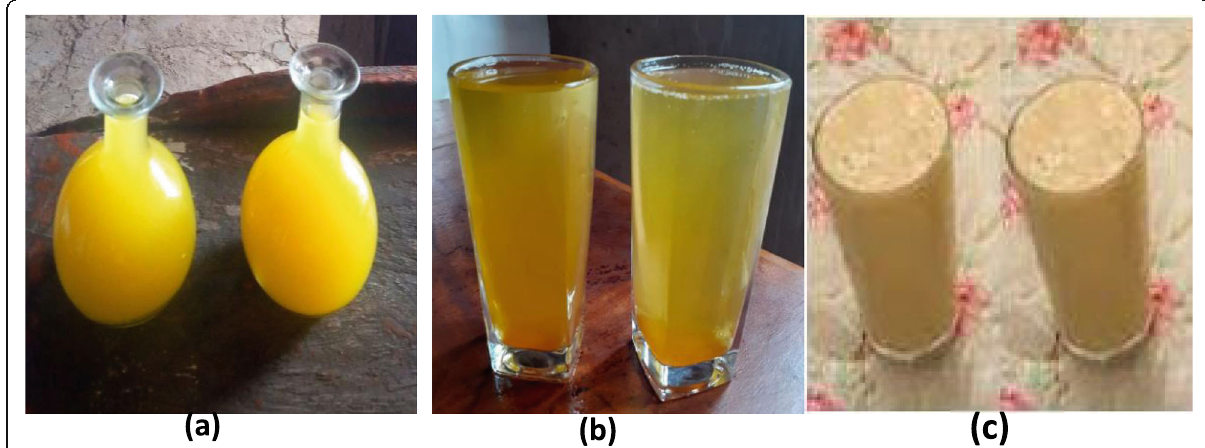
Fig. 4 Pictures of Ethiopian traditional fermented beverages: tej ( a ), grawa ( b ), and borde ( c ). Tej is prepared from honey, water, malt, and chopped stems of hop ( Rhamnus prenoides ), while grawa is made from only honey and water of Qellem Wollega Zone, Anfilo District. Borde is usually made from maize ( Zea mays ) and wheat ( Triticum